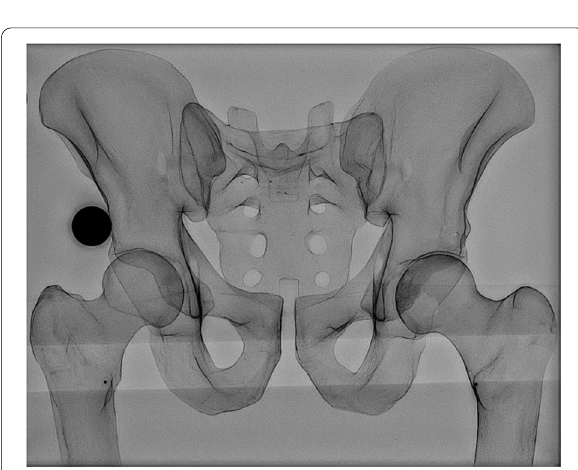
Fig. 2 Anteroposterior (AP) radiograph of the Sawbones model, demonstrating its radiopaque cortical shell. For calibration and reference, a 25-mm steel ball is placed at the level of the acetabulofemoral joint and a 2-mm metallic marker at the